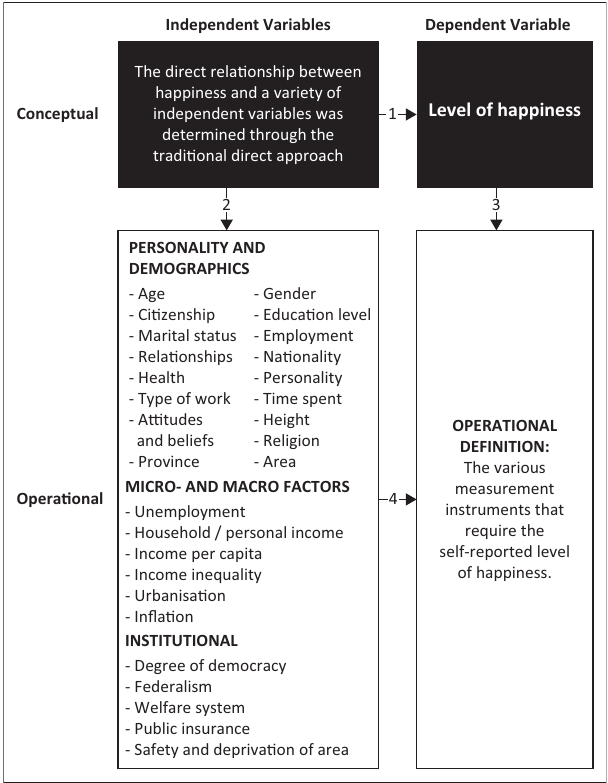
Independent Variables Dependent Variable